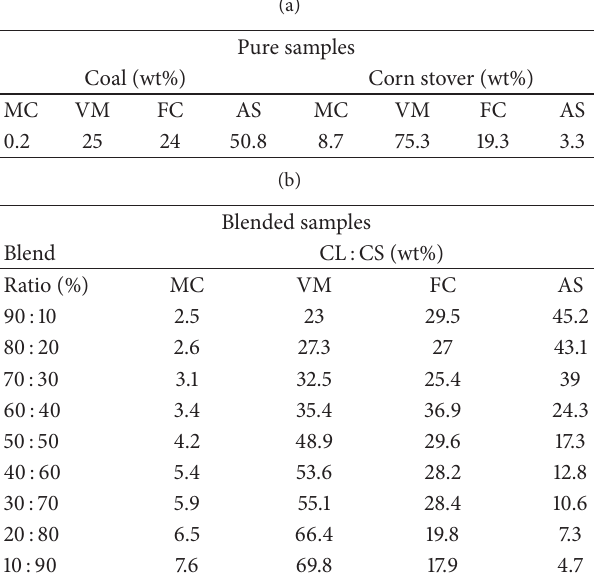
Table 2: Proximate analysis of pure and blended samples of corn stover and coal.